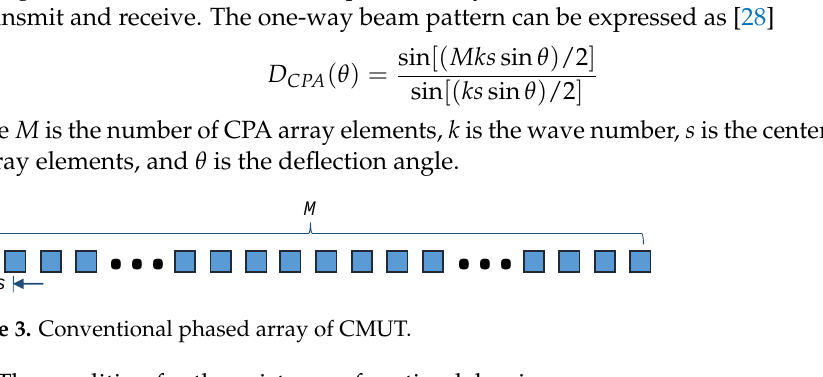
Figure 3. Conventional phased array of CMUT.